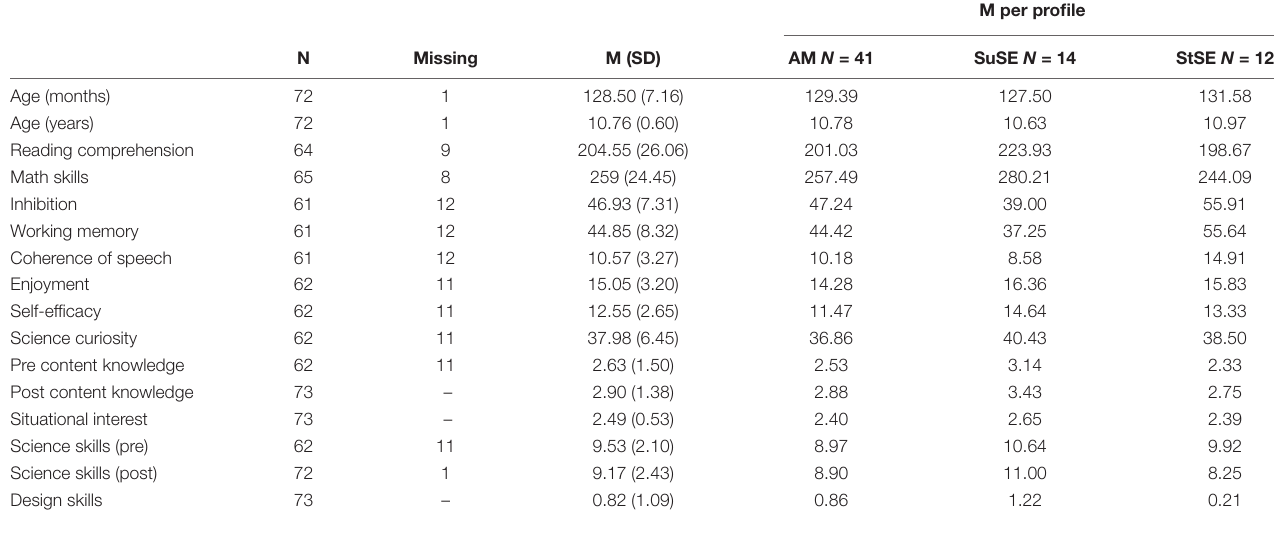
TABLE 4 | Descriptive statistics for the main variables and per latent profile: average majority (AM), successful science enthusiasts (SuSE), and struggling science enthusiasts